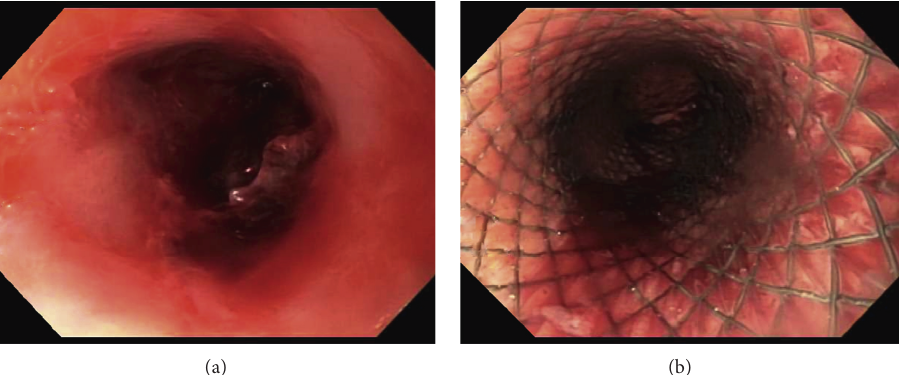
Figure 1: (a) Endoscopic appearance of distal esophagus demonstrating esophageal ulcer with active oozing (blue arrow). (b) Endoscopic appearance of distal esophagus following fully covered self-expanding metal stent (SEMS) (WallFlex ™ Esophageal Stents, Boston Scientific, Marlborough, MA)